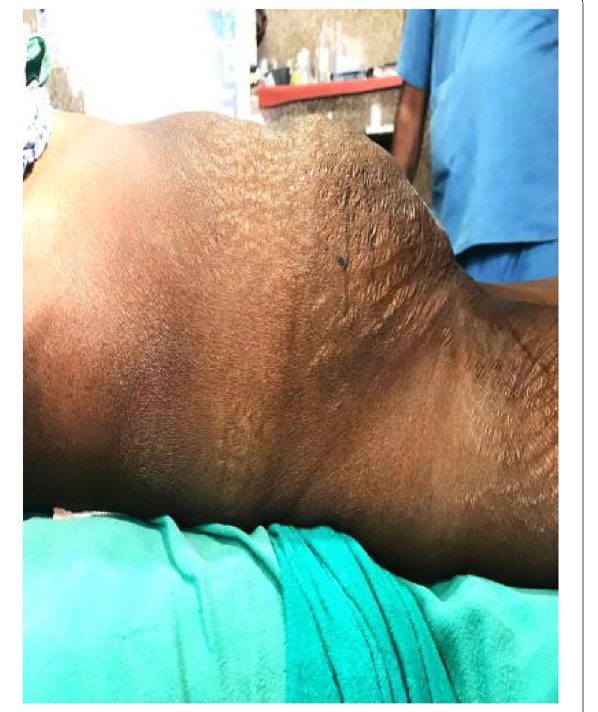
Fig. 2 Ascites resolved post-vaginoperitoneal fistula formation